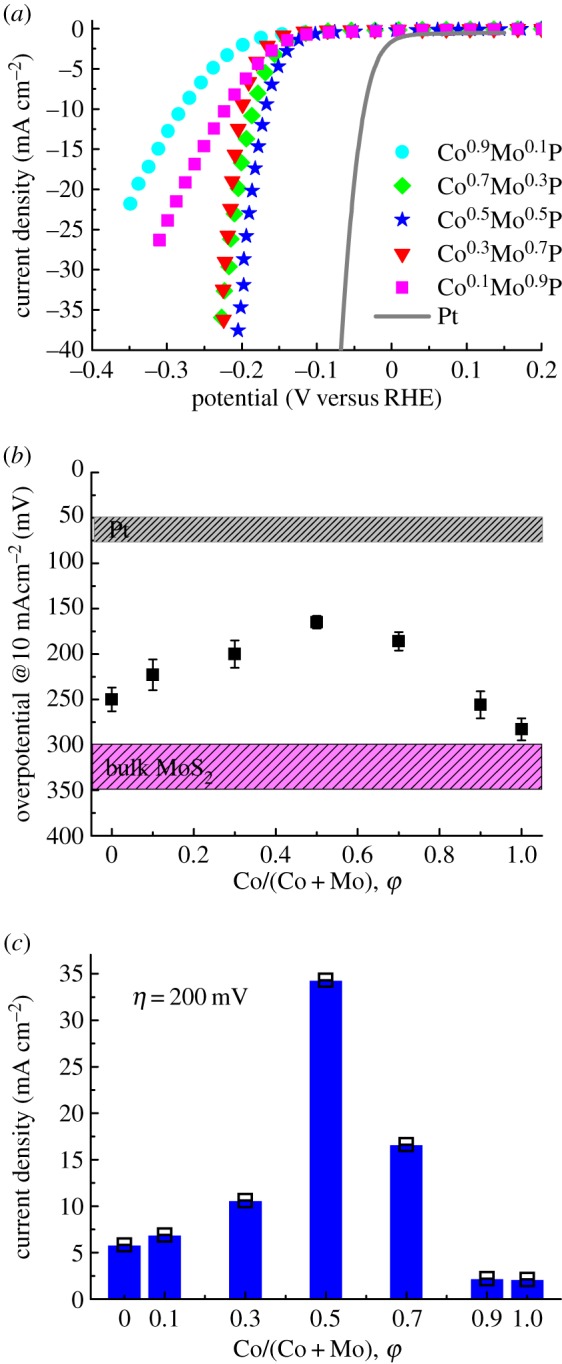
(a) Polarization curves of the CoφMoτP catalysts annealed at 800°C and a Pt foil in hydrogen-purged 0.1 M HClO4. (b) Activity volcano for the HER showing the overpotentials from (a) at current density of 10 mA cm−2 as a function of cobalt content φ. The data of Pt and MoS2 from the literature are also included. (c) The dependence of current density at an overpotential of 200 mV from (a) on the cobalt content.